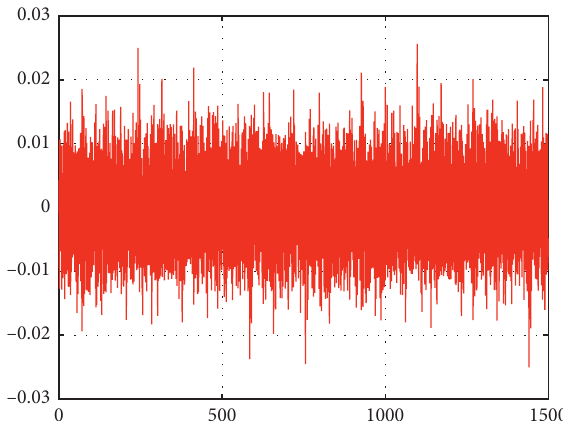
Figure 8: Road roughness derivative in longitudinal direction of the stiffened girder (showing the road roughness and the road roughness derivative of half span length only, the other half is taken symmetrically).